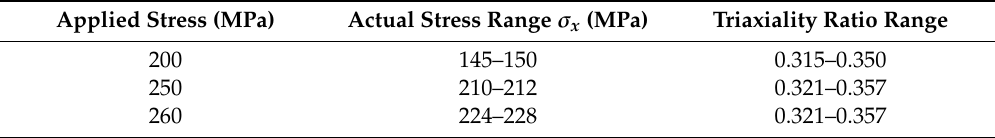
Table 3. Range of actual stress and triaxiality ratios over ROI (Region of Interest) at three applied